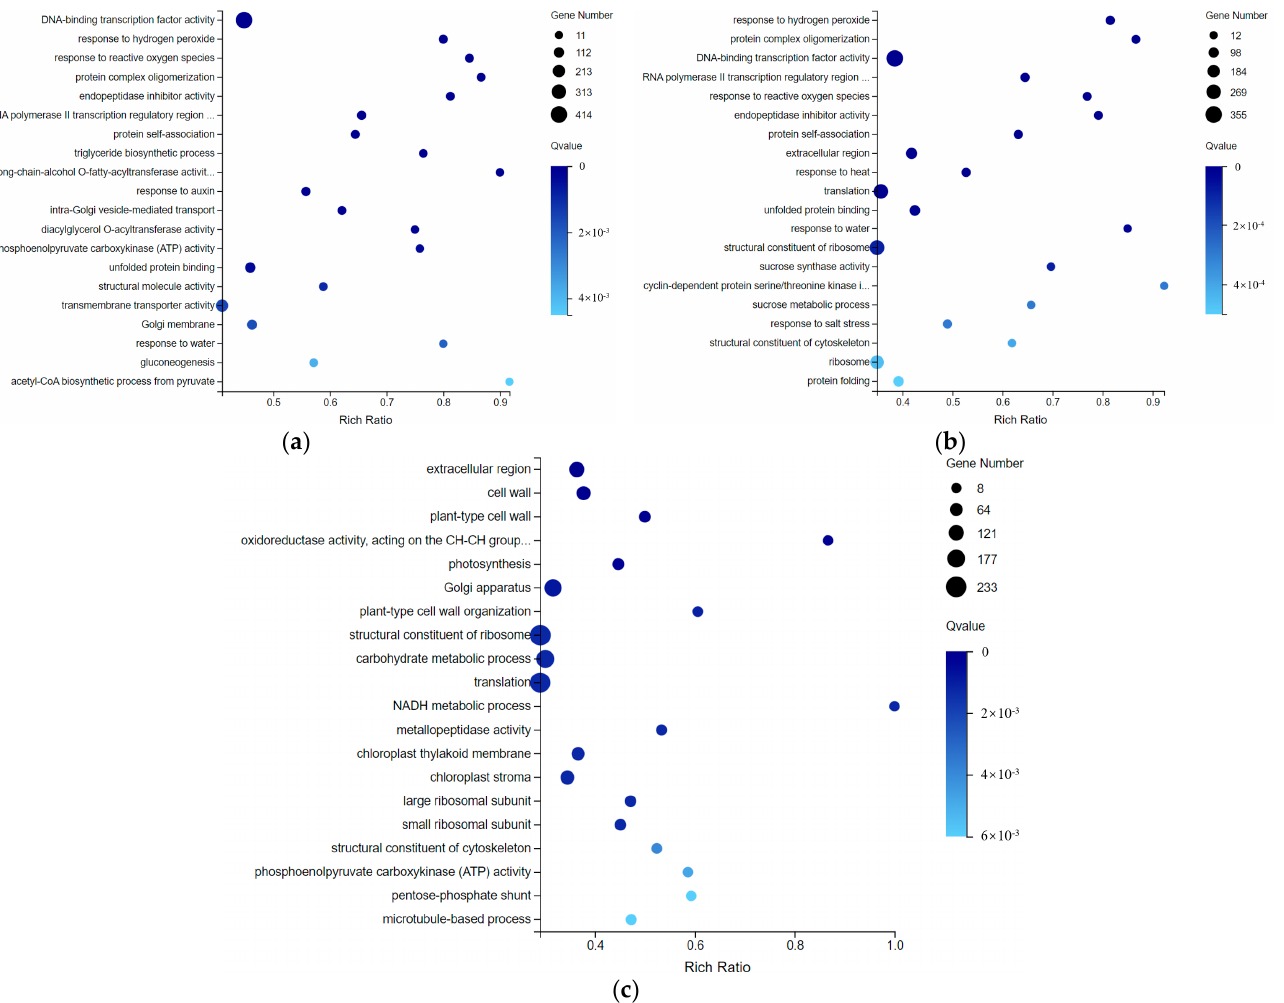
Figure 7. GO pathway enrichment bubble charts. ( a ), ( b ) and ( c ) represent the GO pathway name for DEGs in S1 vs. S2, S1 vs. S3 and S2 vs. S3, respectively. The size of the bubble indicates the number of DEGs annotated on a GO term. The color represents the enriched Qvalue value. The darker the color, the smaller the Qvalue.